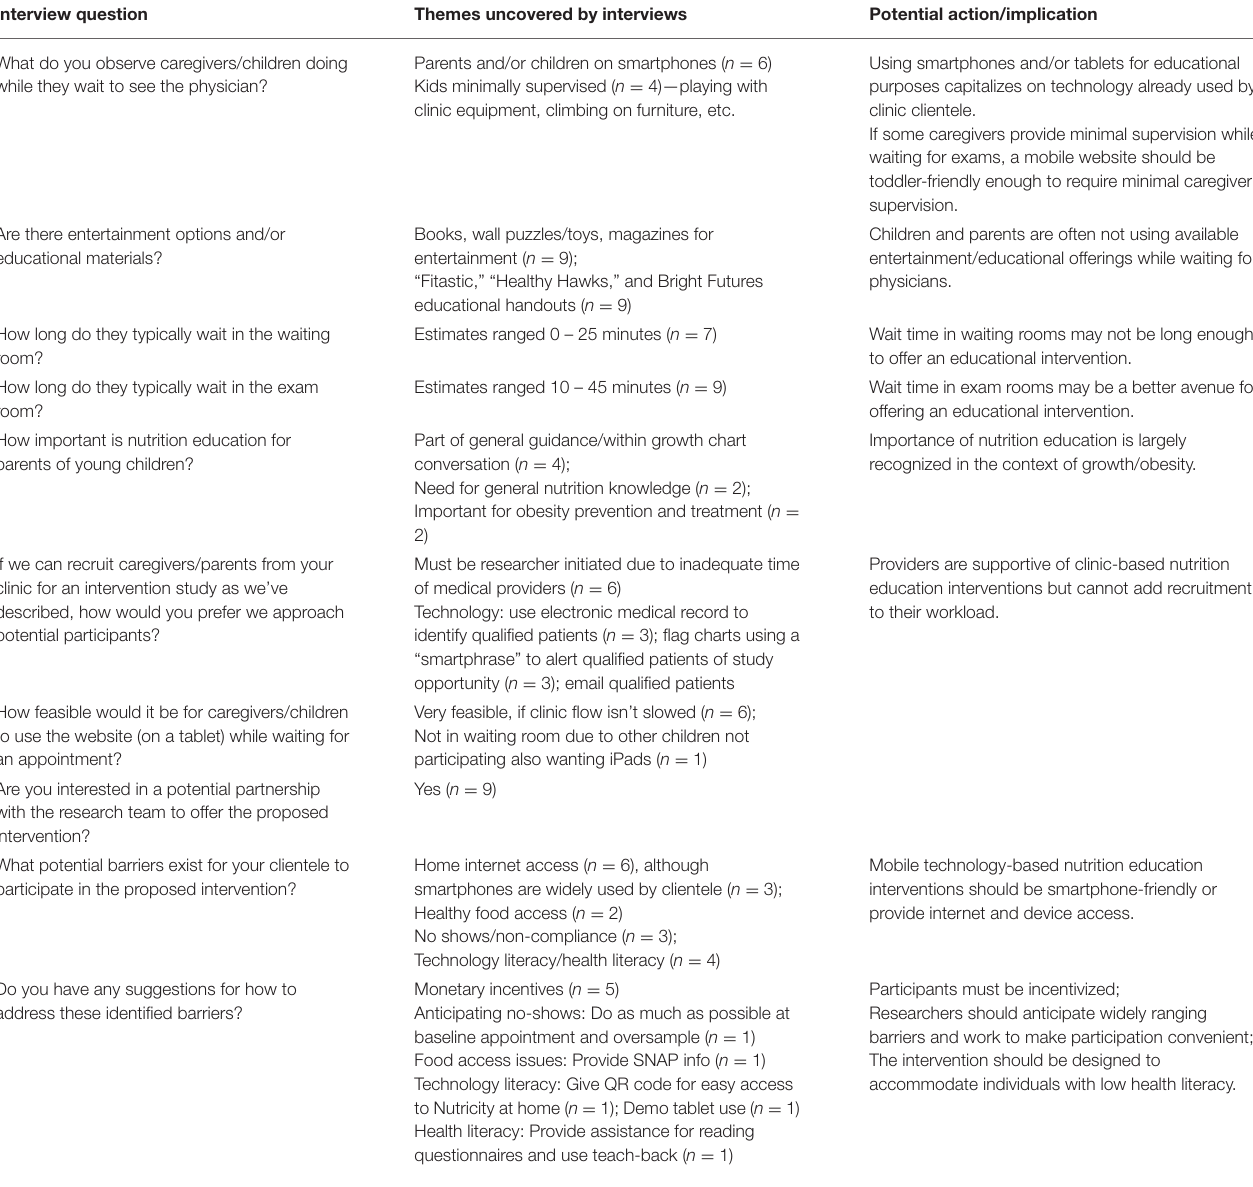
TABLE 2 | Content analysis of interviews ( n = 9) with pediatricians and clinic staff from four metro